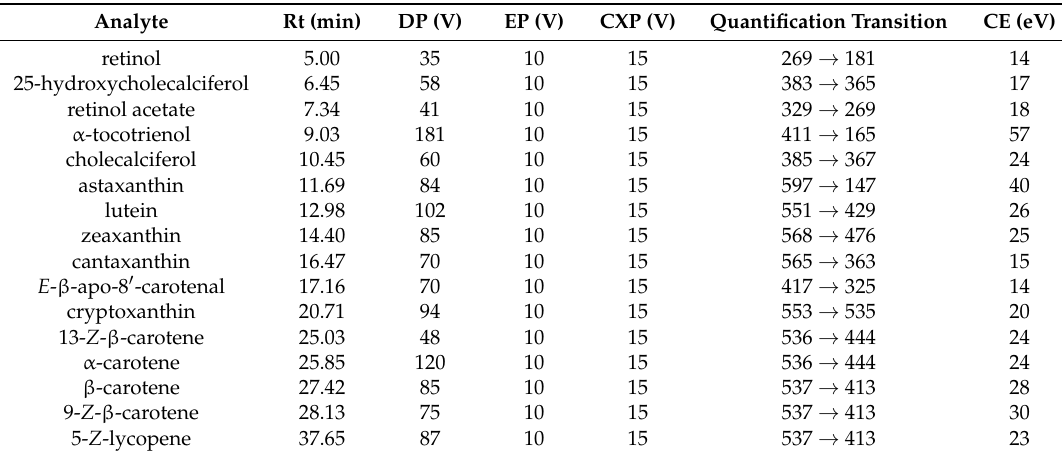
Table 2. Optimized values of declustering potential (DP), entrance potential (EP), cell exit potential (CXP) and retention time (Rt). Quantification transitions of the carotenoids and fat-soluble vitamins with the optimal collision energy (eV).